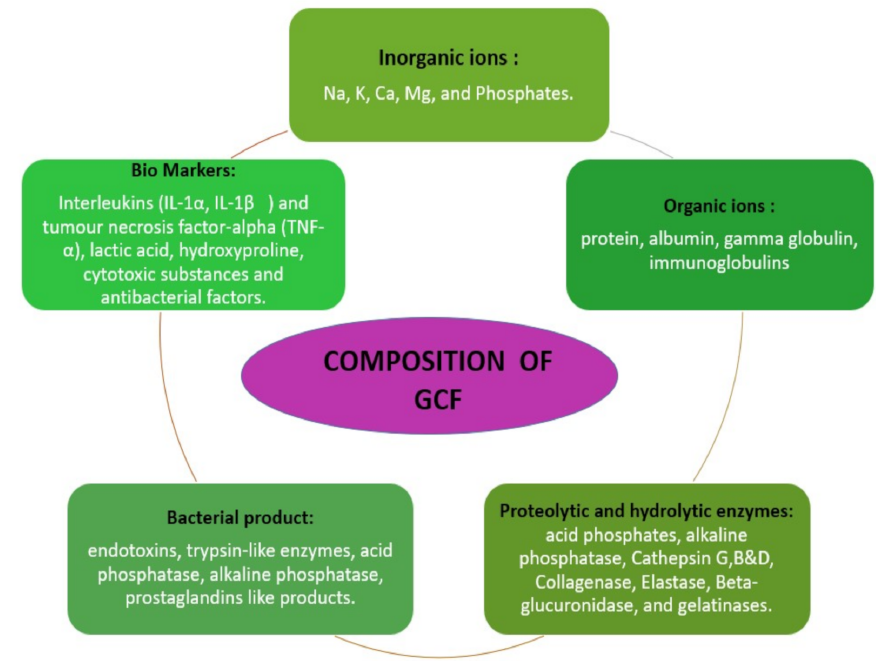
Figure 1. Description of gingival crevicular fluid composition